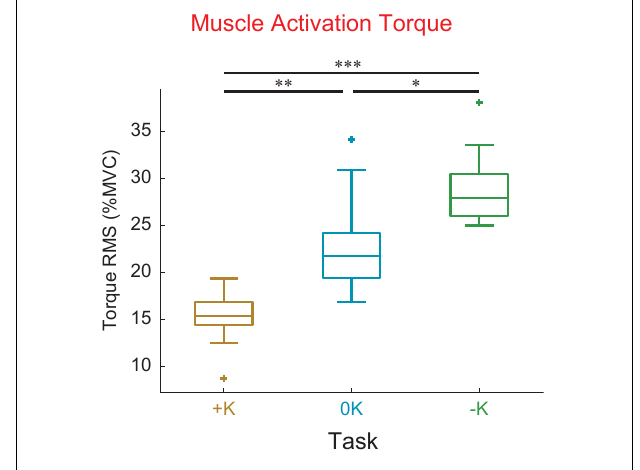
FIGURE 7 | The +K task required subjects to generate less torque due to muscle activation compared to the other two tasks. This was seen both in the mean torque as well as the standard deviation of torque about the mean value. * p < 0.05; ** p <0.01; *** p <